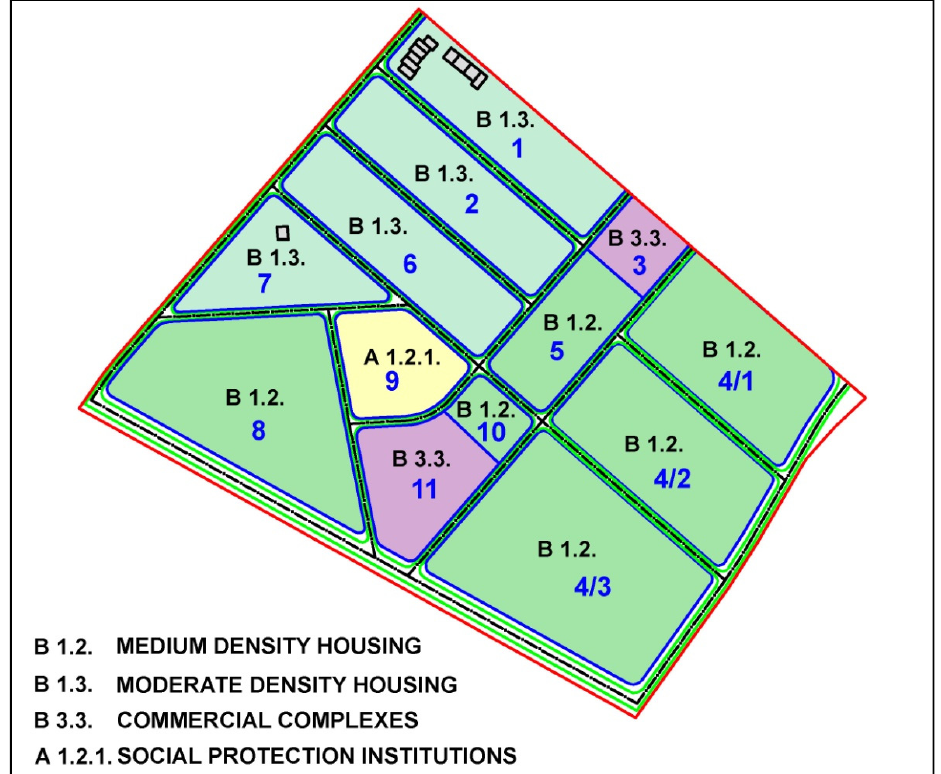
Figure 6. Modifications of the urban plan.